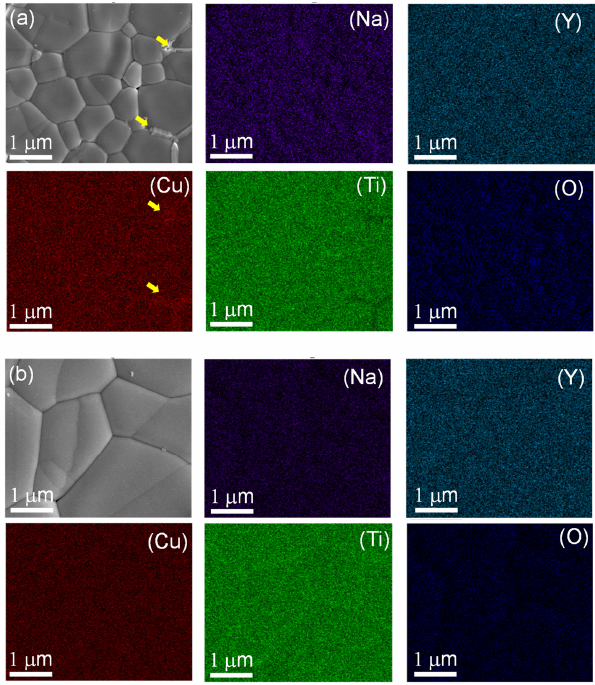
Figure 4. SEM mapping images of Na, Y, Cu, Ti, and O considering the amount of Cu ( a ) and Ti ( b ) at the grain boundary of the Na 1/2 Y 1/2 Cu 3 Ti 4.1 O 12 ceramic sintered at 1070 °C for 15 h.